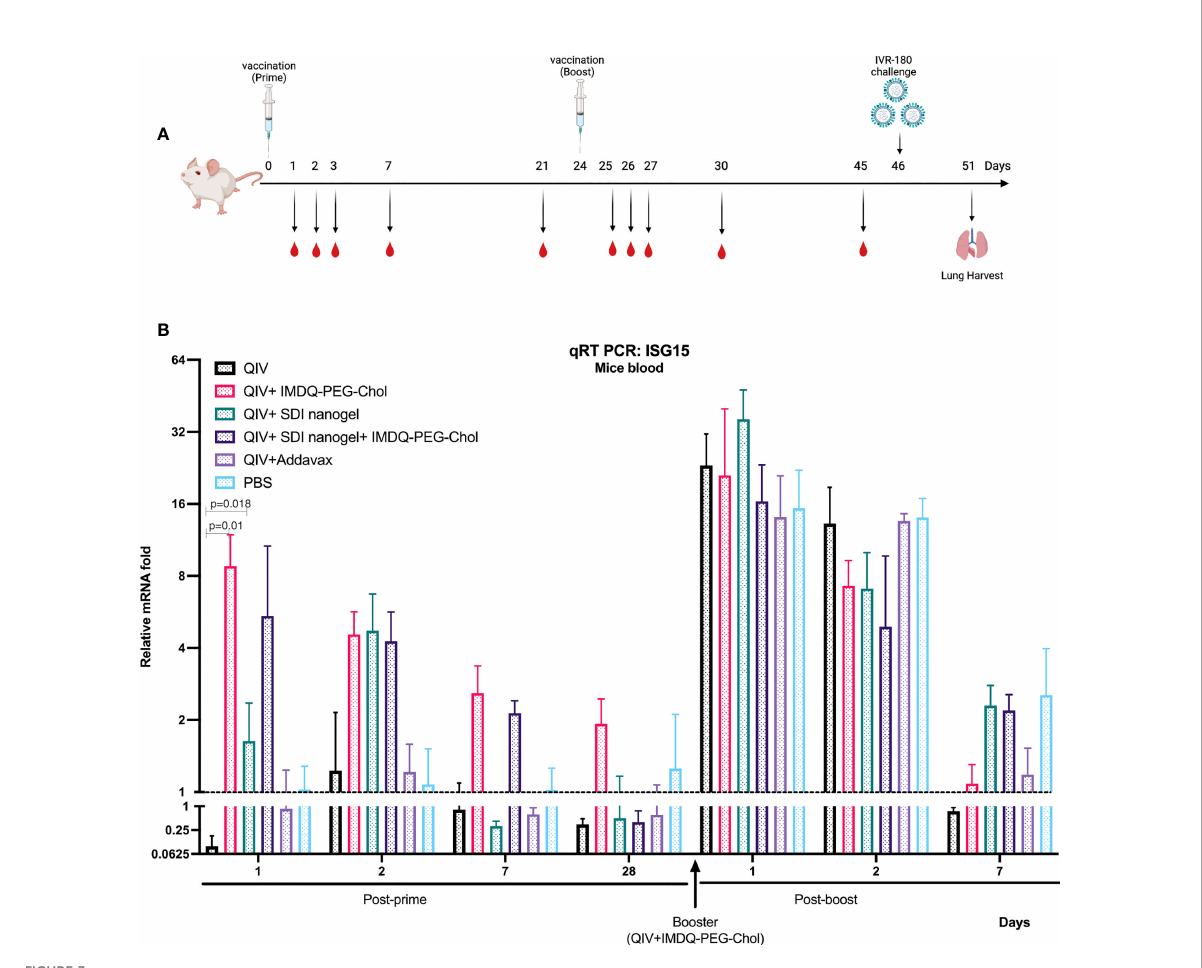
FIGURE 3 QIV combined with SDI+nanogel or/and IMDQ-PEG-Chol induces ISG15 expression: (A) Schematic representation of the experiment. 6-8 weeks BALB/c animals (n=4/group) were vaccinated with unadjuvanted QIV or combined with either SDI+nanogel and/or IMDQ-PEG-Chol and blood was collected at different time points for RNA analysis (created with BioRender.com). (B) Fold induction in ISG15 gene expression in mice from different groups, post-prime and post-boost vaccination. Importantly, all the animals received QIV+IMDQ-PEG-Chol as a booster, irrespective of the vaccination in prime dose. The fold changes are calculated with respect to the PBS group at each time point and represented as geometric mean for each group. GAPDH was used as internal control for the analysis. The error bars represent geometric SD for respective groups. Statistical analysis was performed using two-sided unpaired T test. P values are calculated in reference to unadjuvanted QIV group post- prime